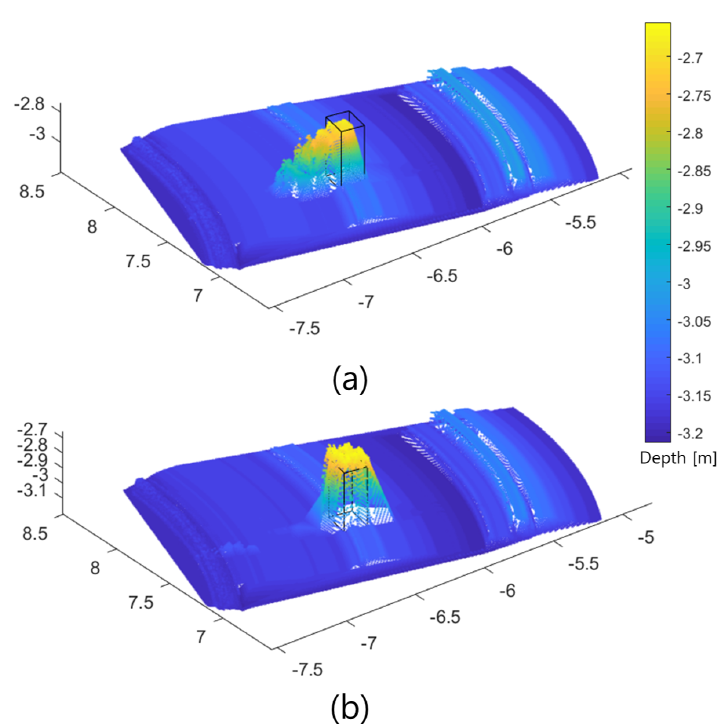
Figure 13. Field test results: ( a ) before combining the two types of sonar data; ( b ) the proposed method. The black solid line shows the size of the reference